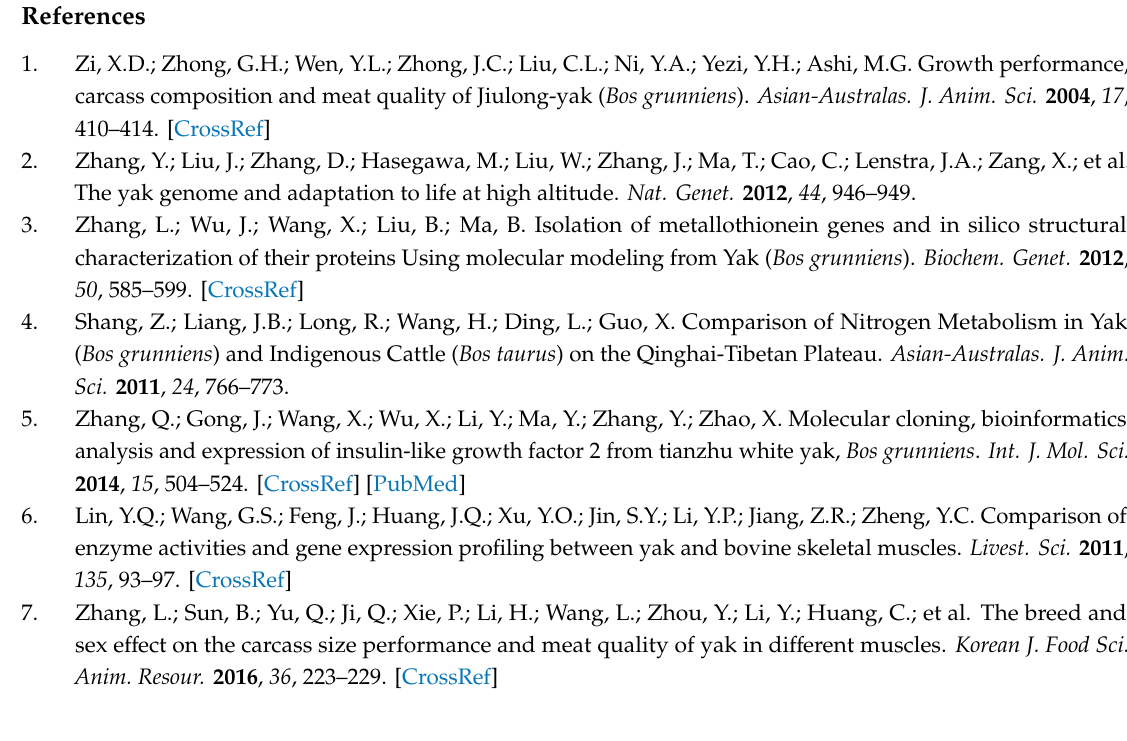
red dashed lines show the portions of the spectra employed for the quantification of each molecule. Below – one representative spectrum (black line) superimposed to the signals simulated by software Chenomx (red line) for each of the molecules listed; Table S1: Concentrations (mmol / g, median (IQR)) of molecules quantified by 1